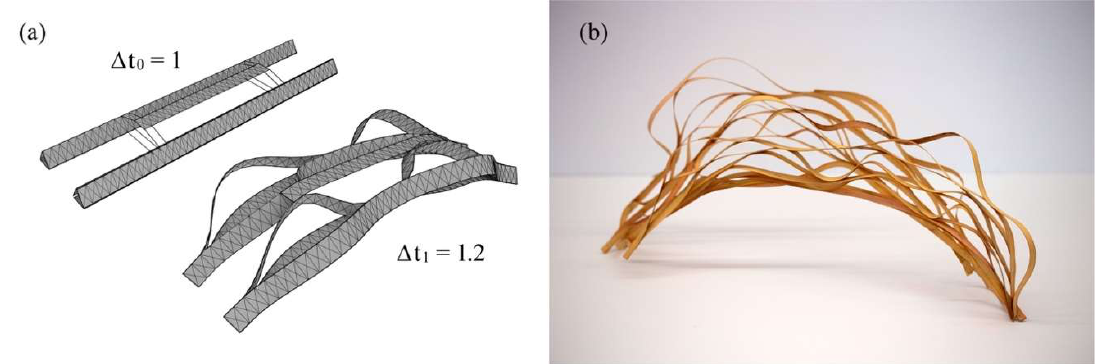
Figure 22. Students use digital growth simulations ( a ) to build strip-based plywood models ( b ).